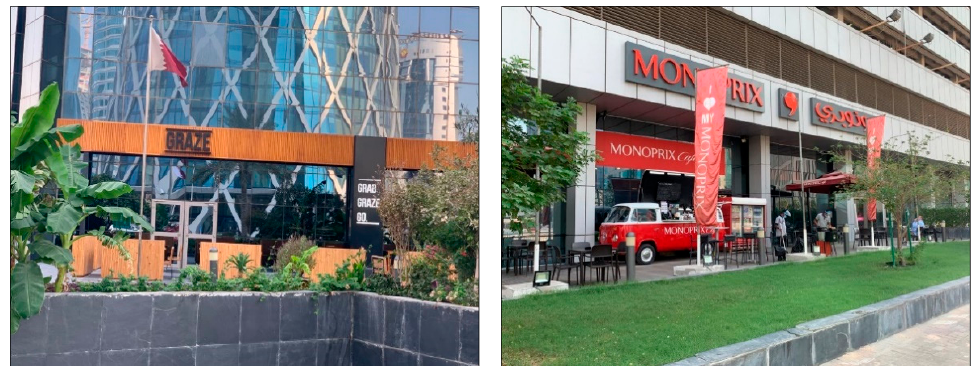
Figure 11. Different tower prototypes (Source: the Authors).